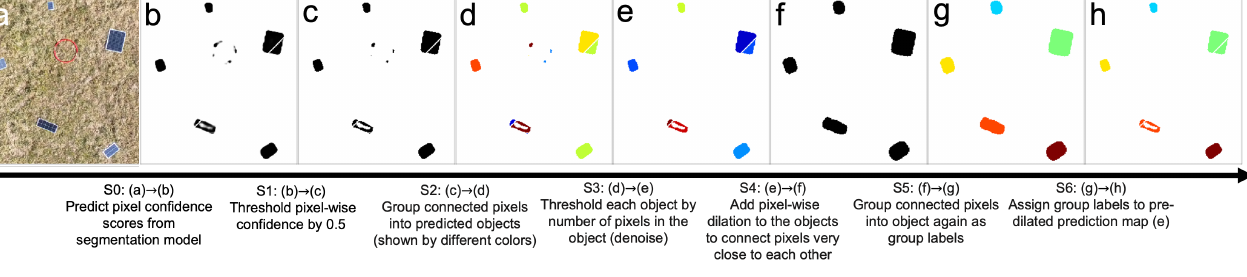
Figure 2. Post-processing diagram. ( a ) Original RGB drone imagery. The post processing step takes as input the prediction confidence map ( b ) from the model output and generates candidate objects through thresholding, grouping, and dilating. ( c – h ) are products of the following steps: Step 1 (S1) thresholds the confidence at 0.5, eliminating the least-confident detections. Step 2 (S2) matches connected pixels into groups of pixels (groups shown in different colors). Step 3 (S3) eliminates the groups of pixels that are too small (likely noise). Until this point, some pixels that corresponds to the same solar panel appear disconnected and therefore belong to different groups. Steps 4 and 5 address this issue by dilating the proposal pixels (S4) and grouping them (S5). To ensure the dilation does not change the overall area of prediction, we assign the groups based on the pre-dilation map, but with the dilated grouping by label point-wise